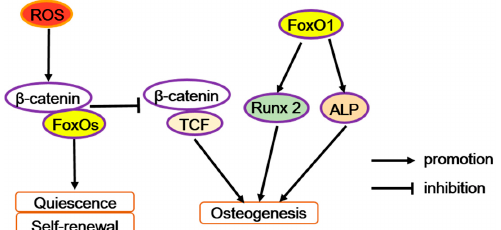
Figure 2. The diverse function of FoxOs in osteoprogenitor cells. Reactive oxygen species (ROS) can trigger FoxOs mediated transcription and enhances the binding of FoxOs to β -catenin, thus diverting